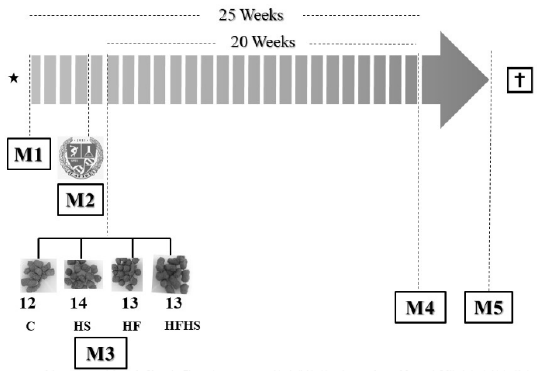
Figure 1. Schematic representation of the experimental design for 20 weeks. The weeks are represented by individual bars in arrow format. Moment 1 (M1): Animals’ births (Animal Quarters of the Federal University of Espírito Santo (Brazil); Moment 2 (M2): Rats were habituated to the laboratory (Experimental Laboratory of Experimental Physiology and Biochemistry—LAFIBE) and the experimenter for 7 days; Moment 3 (M3): Beginning of the experimental protocol and randomization of groups: control diet (C), high-sugar diet (HS), high-fat diet (HF), and high-fat and high-sugar diet (HFHS)—(week 0); Moment 4 (M4): In vivo analysis during one week (glucose tolerance test and cardiovascular profile) after 20 weeks; Moment 5 (M5): End of experimental protocol, euthanasia, and post mortem analysis (characterization of obesity, nutritional profile, metabolic and hormonal measurements, organ weights, and water content determination).